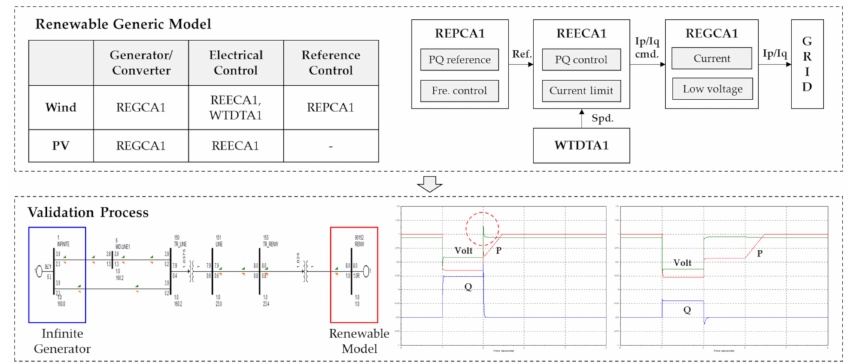
Figure 4. Dynamic model of renewable energy.